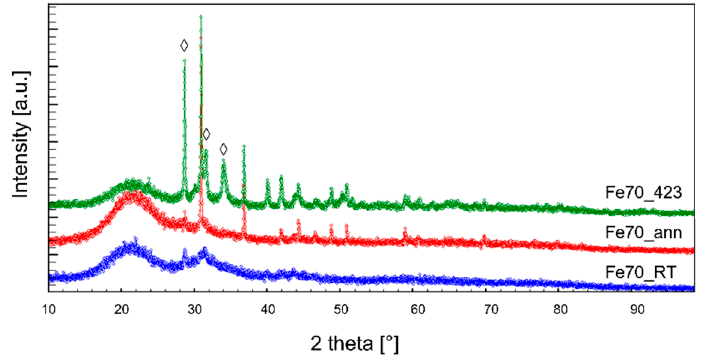
Figure 8. X-ray diffraction patterns of films belonging to the Fe70 series ( ◊ refers to the secondary phases Sm and SmSb 2 ).